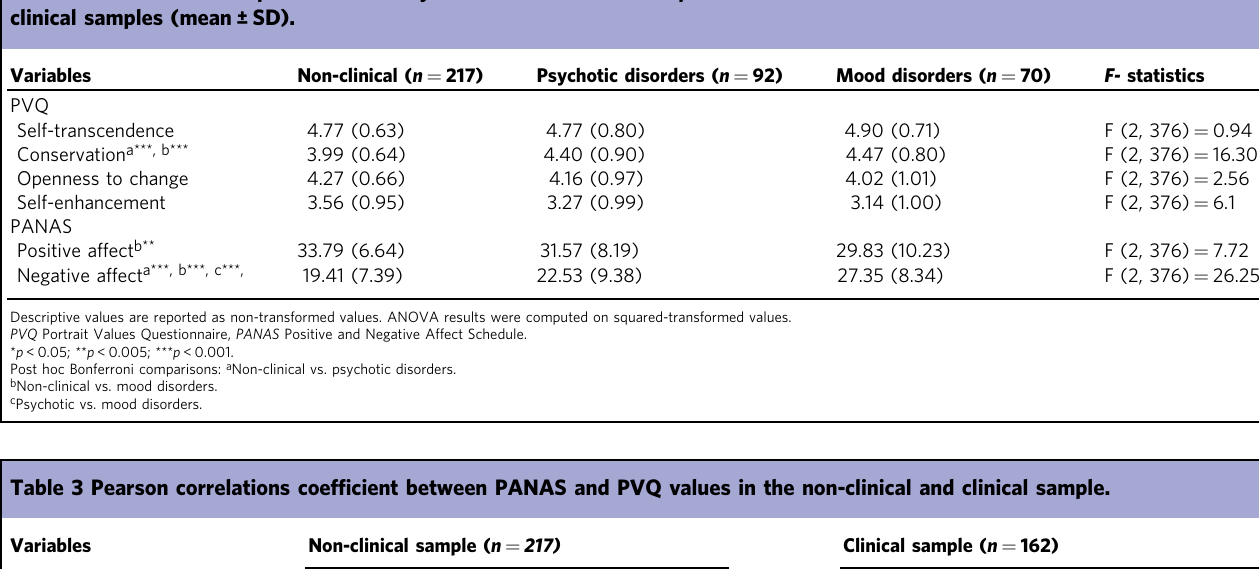
Table 2 Mean scores comparison (one-Way ANOVA with Bonferroni post hoc test) of values and affects in the non-clinical and clinical samples (mean ± SD).